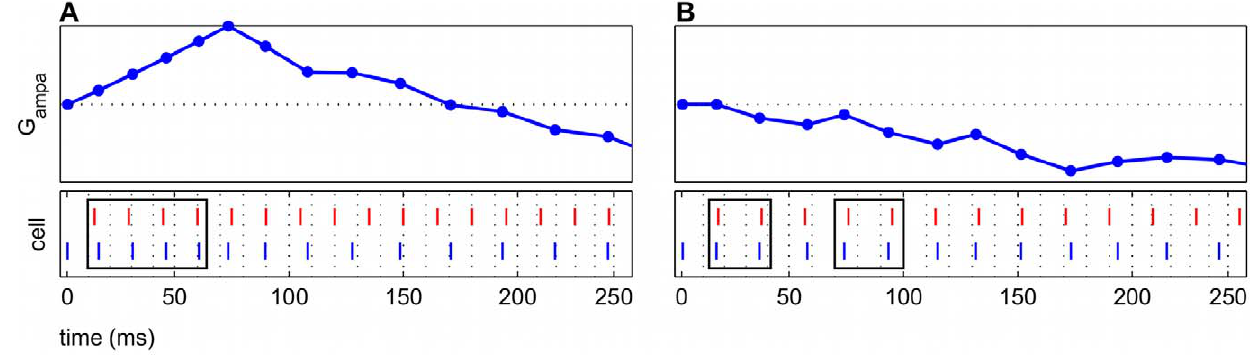
Figure 4. Potentiation and depression are expressed in the model as changes in the AMPAR conductance. The bottom panels show raster plots of the input spikes (red) and E cell spikes (blue). (A) Potentiation is shown for one frequency regime ( f N ~ 45 Hz, f I ~ 67 Hz). The boxes in the bottom panel indicate primary potentiating spike pairs in which the input spikes immediately precede the E cell spikes. (B) Depression is shown for one frequency regime ( f N ~ 43 Hz, f I ~ 53 Hz). The boxes in the bottom panel highlight spike pairs that show E cell spikes (blue) preceding input spikes (red).